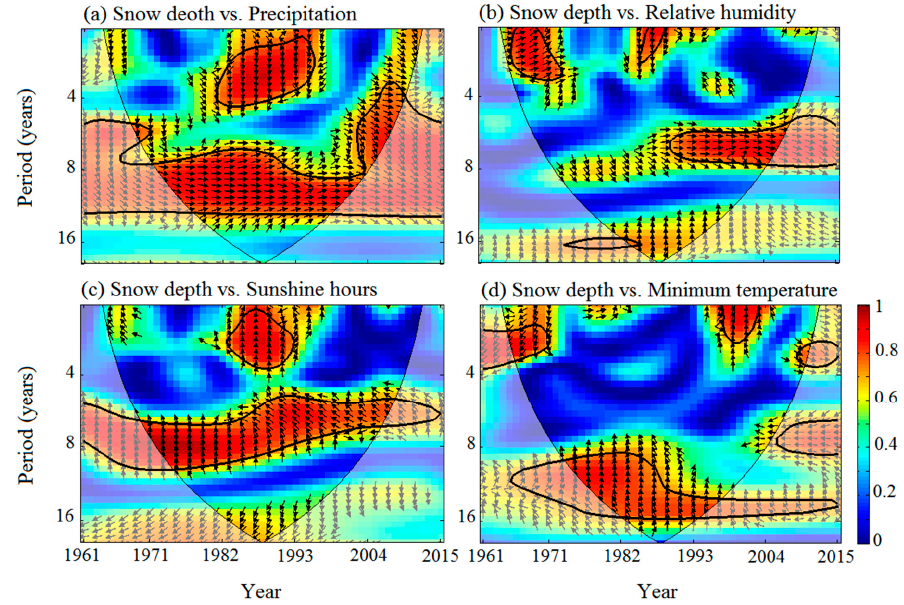
Figure 13. The wavelet coherence spectra between annual snow depth and ( a ) annual precipitation, ( b ) relative humidity, ( c ) sunshine hours and ( d ) minimum temperature over 1961–2015 in Xinjiang. The arrows indicate the phase relationship, the arrows pointing to the right and left indicate in-phase and inversion, while the vertical downward and vertical upwards indicate that the wavelet transform of the annual snow depth is ahead and behind one quarter period of each climate variable. Black outlines indicate areas significant at the 95% confidence level.